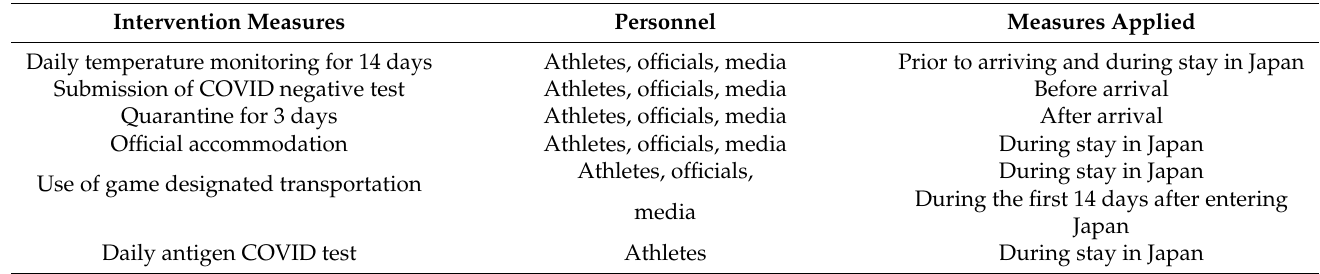
Table 1. Infection control measures implemented during Tokyo Summer Olympics in 2021 [14] (In- ternational Olympic Committee Tokyo 2020